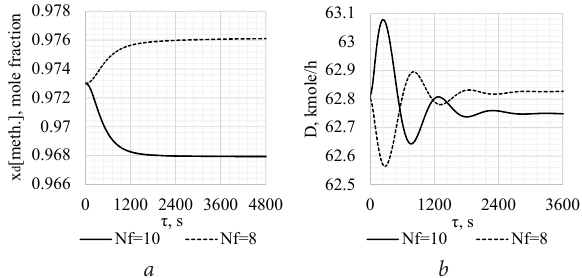
Fig. 1. Transient responses when changing the number of the feed tray by the channels: a – “number of the feed tray – concentration of methanol in the distillate”; b – “number of the